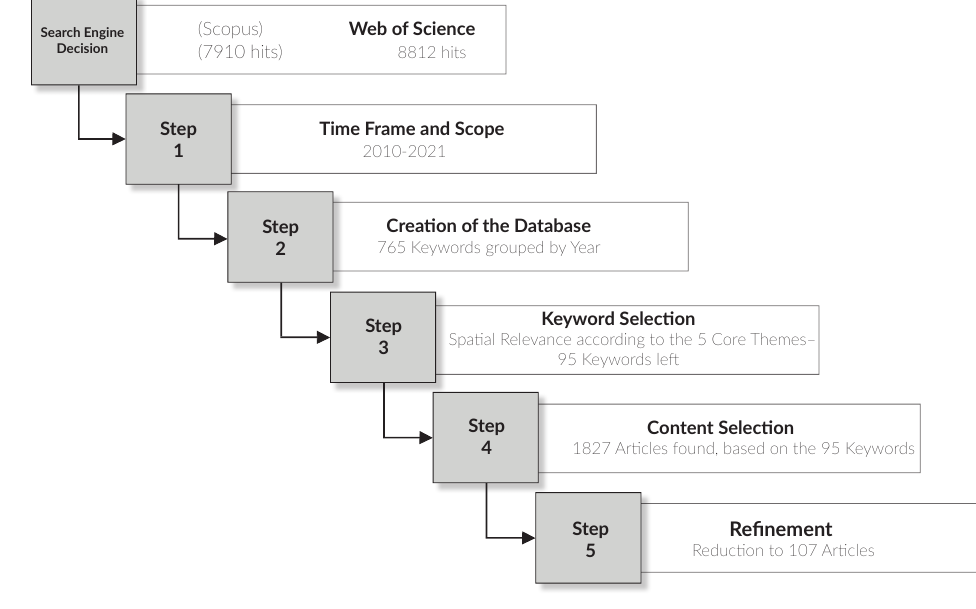
Figure 1. Selection